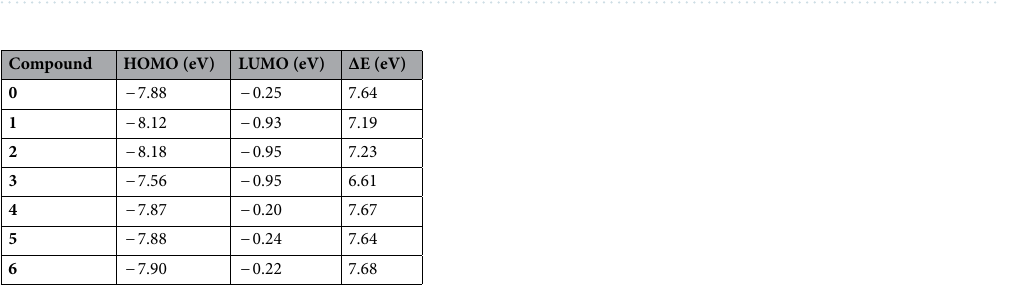
Table 3. Frontier molecular orbitals energies and energy of HOMO → LUMO excitation of compounds 0 and 1 – 6